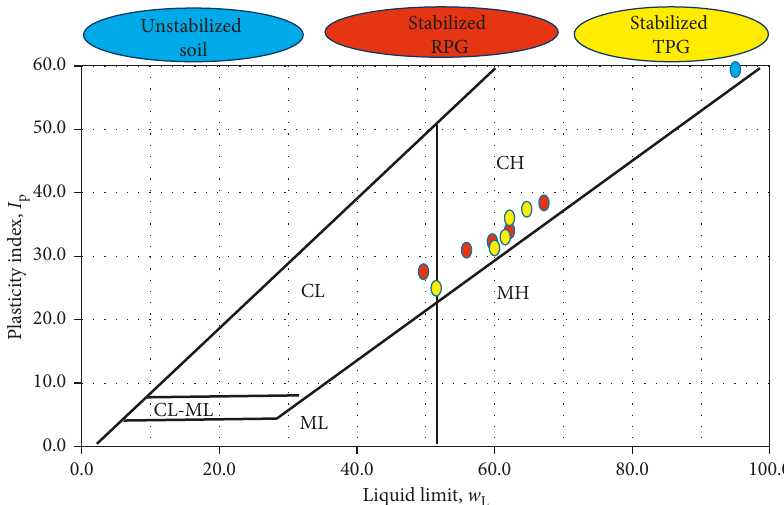
Figure 2: Plasticity chart for the stabilized